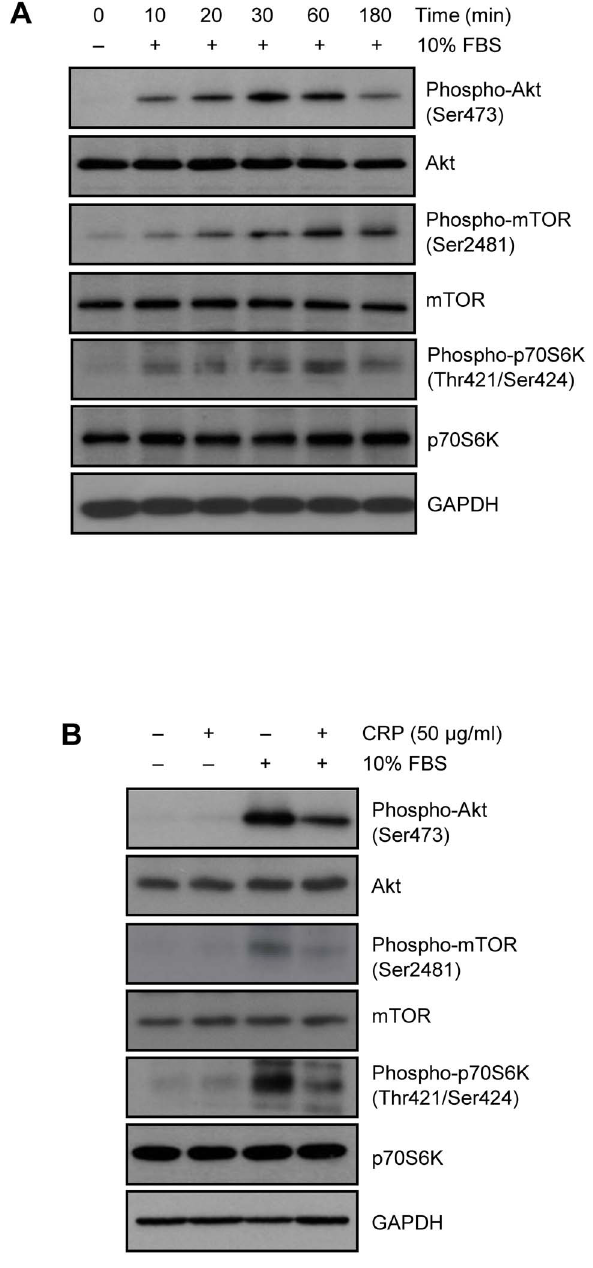
Figure 2. Effect of CRP on the Akt/mTOR/p70S6K pathway in H9c2 cardiac myocytes. (A) After 24 hours of serum starvation, H9c2 cells were treated with 10% FBS for indicated time. Cells were harvested and analyzed for Akt/mTOR/p70S6K signaling pathway by immunoblot assay. (B) H9c2 cells were pretreated for 24 hours with 50 m g/ml of CRP in 0.5% FBS and then treated 10% FBS for 1 hour. The protein levels were analyzed by immunoblot assay.